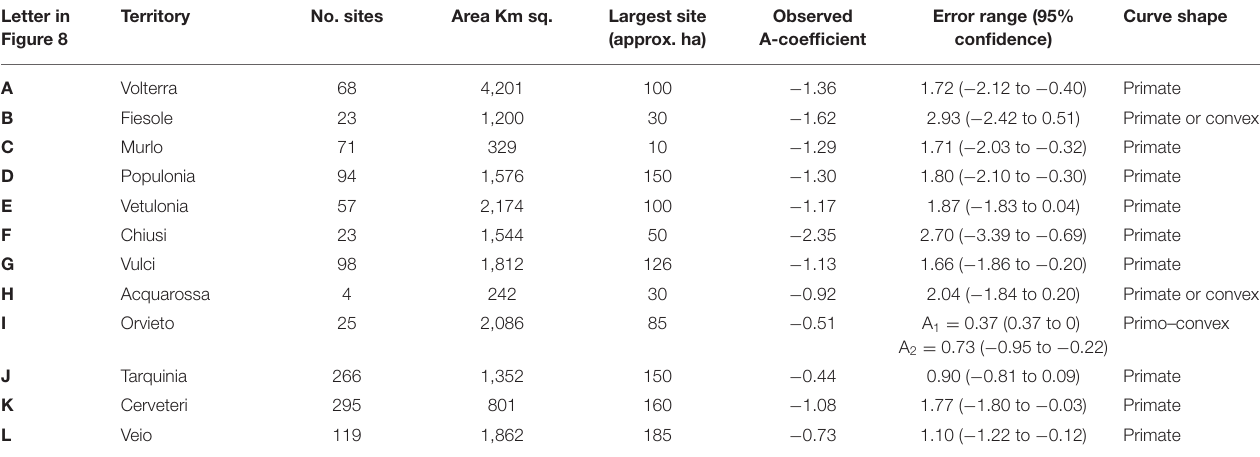
TABLE 4 | A-coefficient values and bootstrapped error ranges for log scale rank-size curves of the XTENT-defined territories in Etruria in the Archaic period. Letter in Territory Curve Figure 8